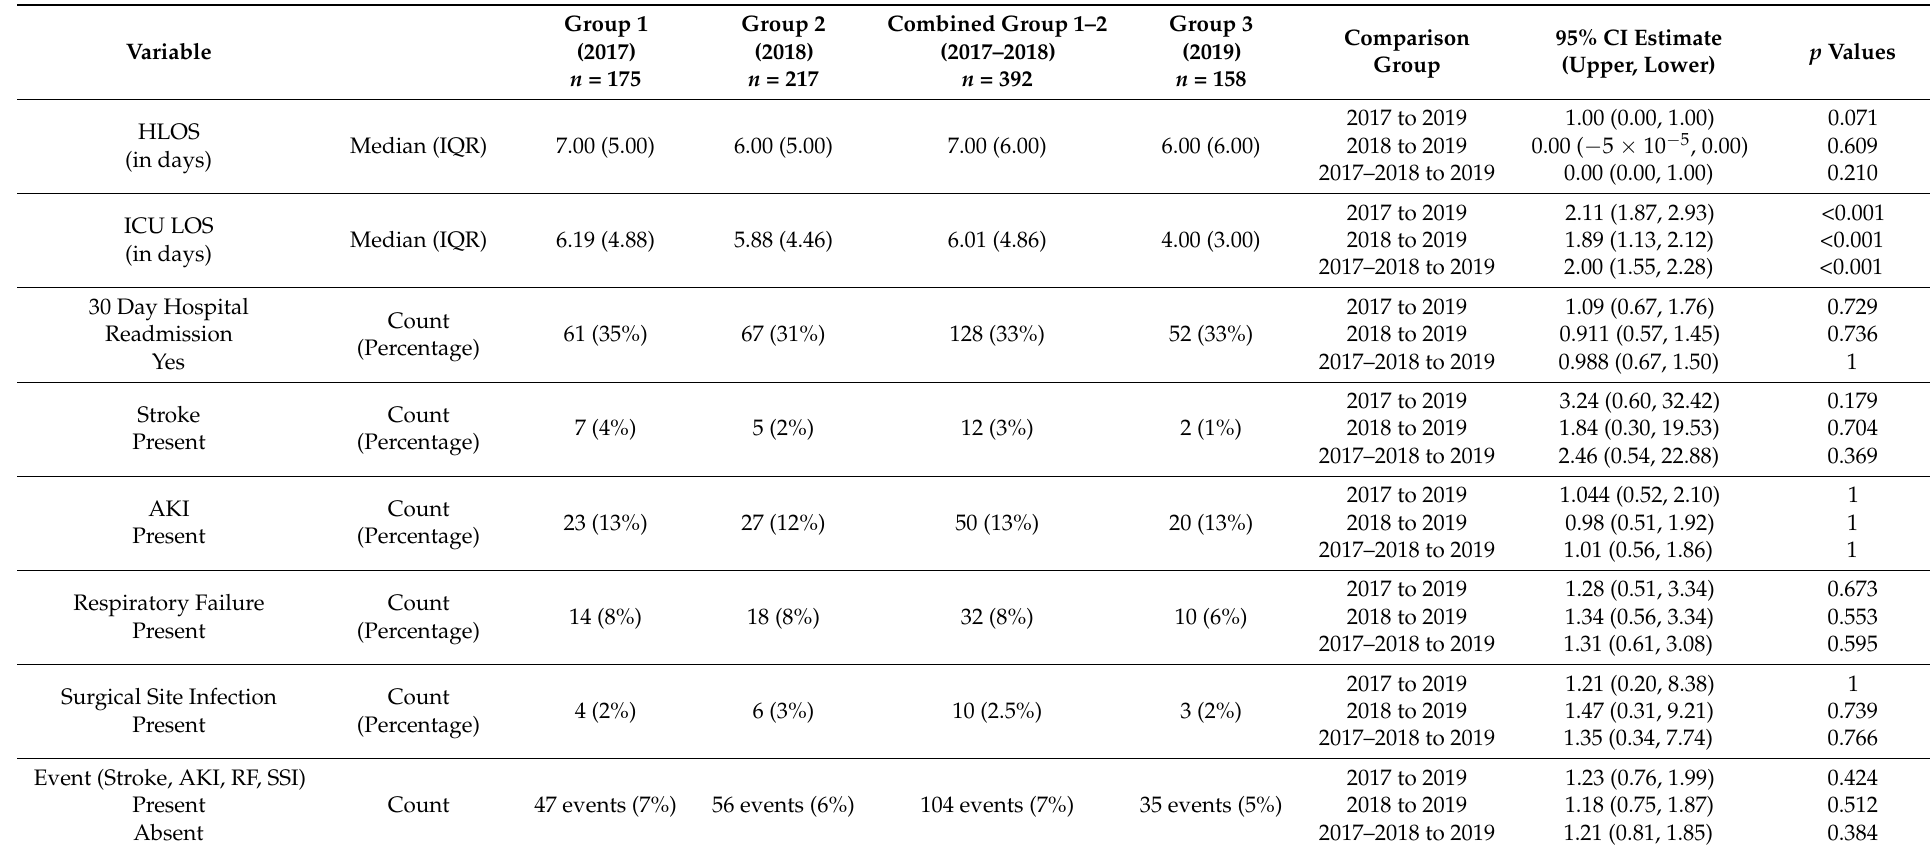
Table 2. Study Outcome Measures. All complications were determined based on electronic health record review for documented diagnosis during ICU stay.